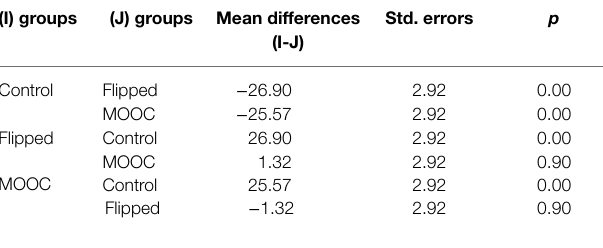
TABLE 4 | Post hoc Scheffe test, multiple comparisons (anxiety